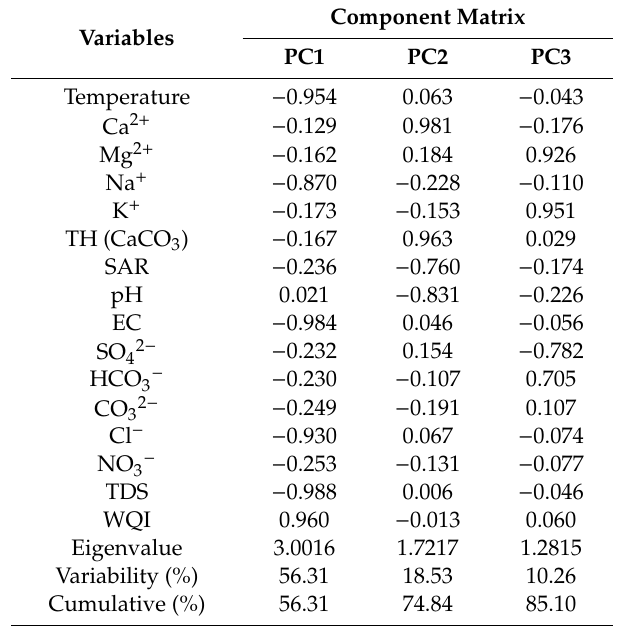
Table 6. Summary of the principal component analysis (PCA) loading after Varimax rotation. Component Matrix Variables